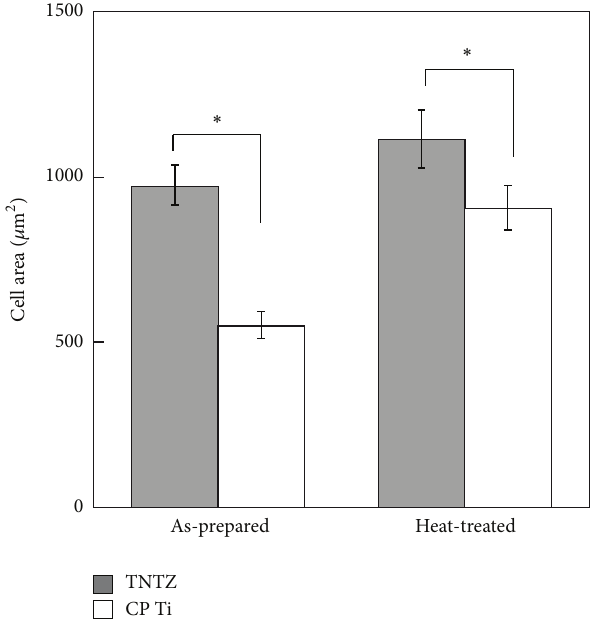
Figure 7: Individual cell area after culturing on TNTZ or CP Ti surface for 1 day. Heat treatment condition: 1000 ∘ C, 1hr.